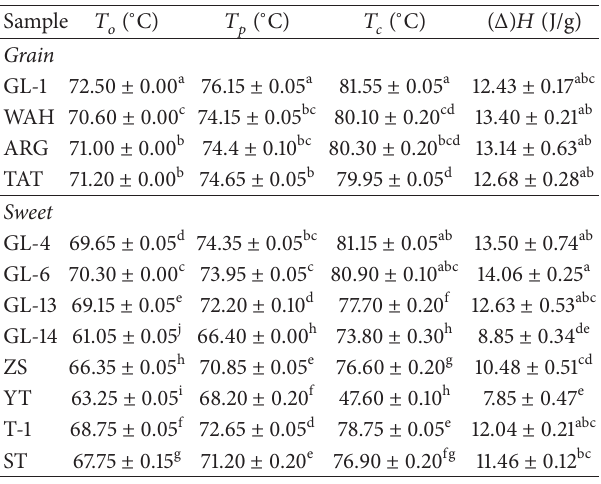
Table 4: The XRD and 13 C CP/MAS NMR chemical shifts of starches from sweet and grain sorghum